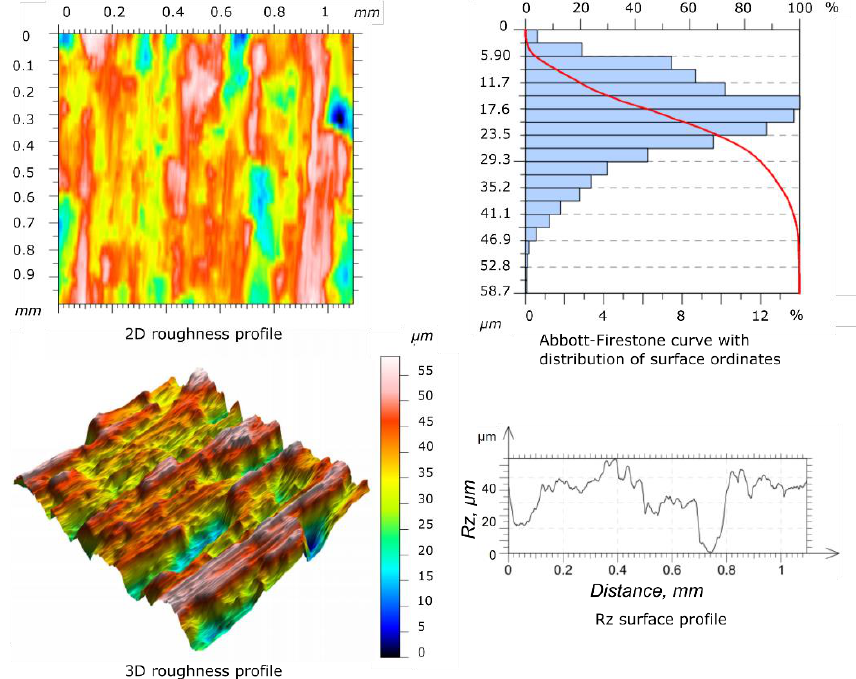
Figure 10. Geometric structure of the surface after the wear tests for counter-specimen (conditions of test: F = 0.1 N, α = 10°, f = 5 Hz).